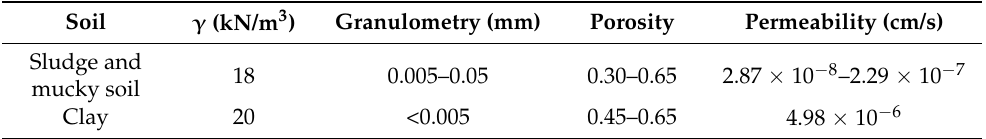
Table 1. Soil parameters of the test region. Table 1 . Soil parameters of the test region.